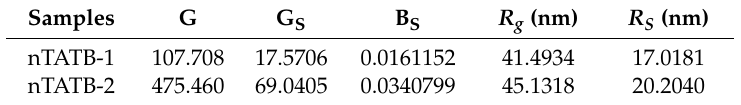
Table 2. Summary of fitting parameters of the nano-sized TATB at the contrast match point. Samples